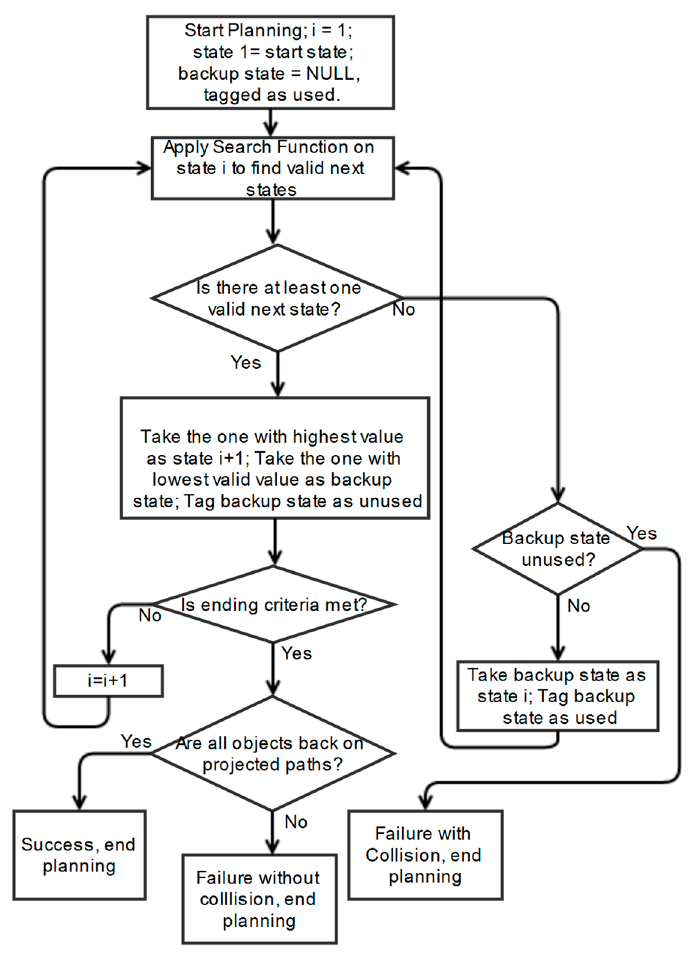
Figure 8. Action phase flow